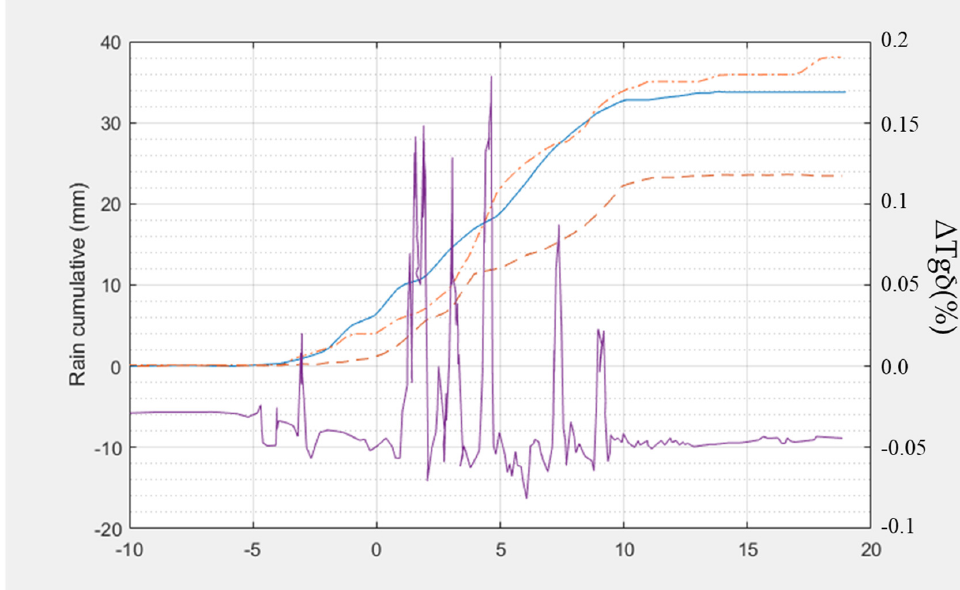
Figure 19. Evolution of the change in the dielectric loss factor ( Δ tag( δ )) depending on the amount of rain measured in 3 weather stations near a power transformer (data available in [66]). Rain cumulative at weather station 1 (blue line), rain cumulative at weather station 2 (orange dotted line), and rain cumulative at weather station 3 (red dashed line).